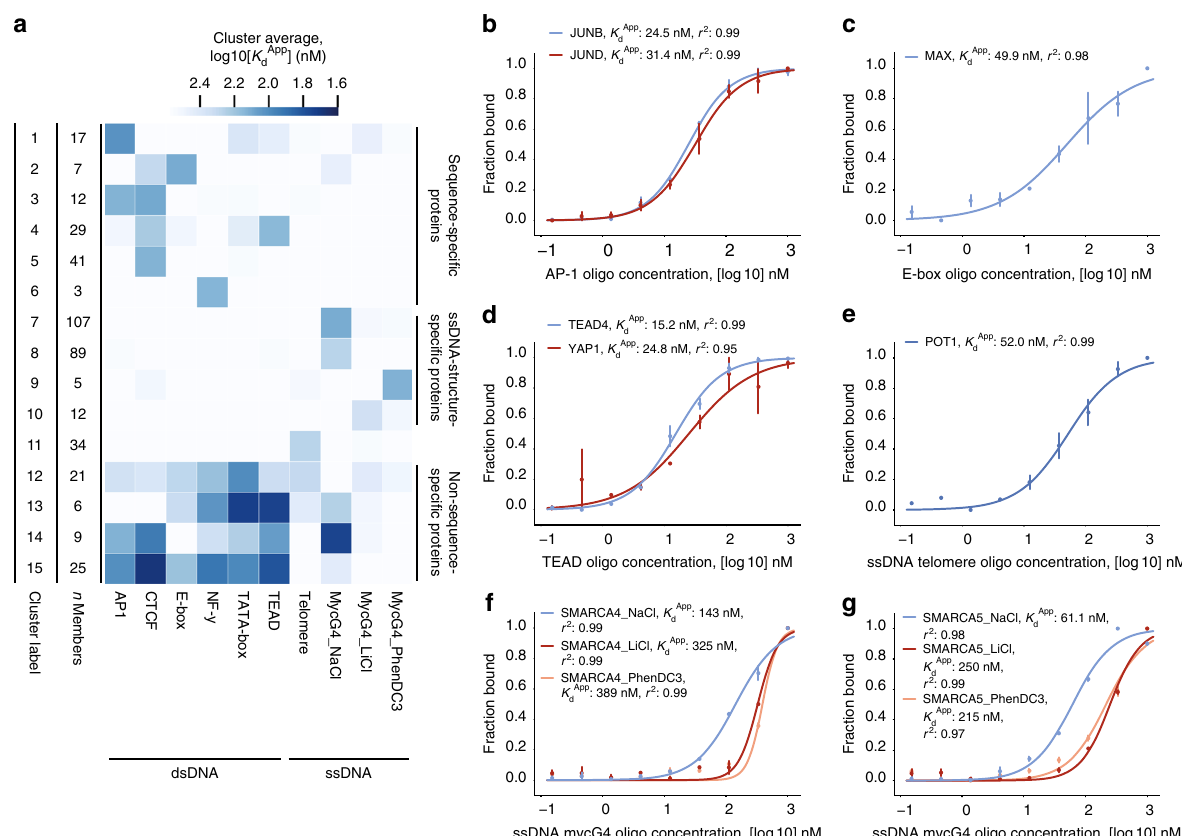
Fig. 2 A motif survey identi fi es SWI/SNF and ISWI factors binding to G4-quadruplex structures. a Heatmap analysis K d App binding pro fi les for all dsDNA and ssDNA sequences and experiments. Proteins were clustered (15 clusters) using hierarchical agglomerative clustering. The heatmap is colored by the average log 10[ K d App ] value of the cluster per bait. Cluster labels and number of proteins per cluster ( n ) are listed in columns to the left of the heatmap. b – g App binding curves for canonical and unreported binding proteins for some example dsDNA and ssDNA motifs. b K K d motif and dimeric binding factors JUNB (Cluster 15) and JUND (Cluster 3). c K d App binding curve for E-box dsDNA motif and dimeric binding factor MAX (Cluster 2). d K d App binding curve for TEAD dsDNA motif and dimeric binding factors TEAD4 (Cluster 4) and YAP1 (Cluster 4). e K d App binding curve for the telomere ssDNA motif (four repeats) and binding factor POT1 (Cluster 11). f K d App binding curve for the mycG4 ssDNA motif in NaCl (G4-permissive), LiCl (G4-nonpermissive), and PhenDC3 (G4-ligand) binding conditions and SWI/SNF binding factor SMARCA4 (Cluster 7). g K d App binding curve for the mycG4 ssDNA motif in NaCl, LiCl, and PhenDC3 binding conditions and ISWI binding factor SMARCA5 (Cluster 7). For b – g , binding curves were generated by fi tting the parameters of the Hill equation including K d App . Each data point is the mean of two experiments ( n = 2), and the error